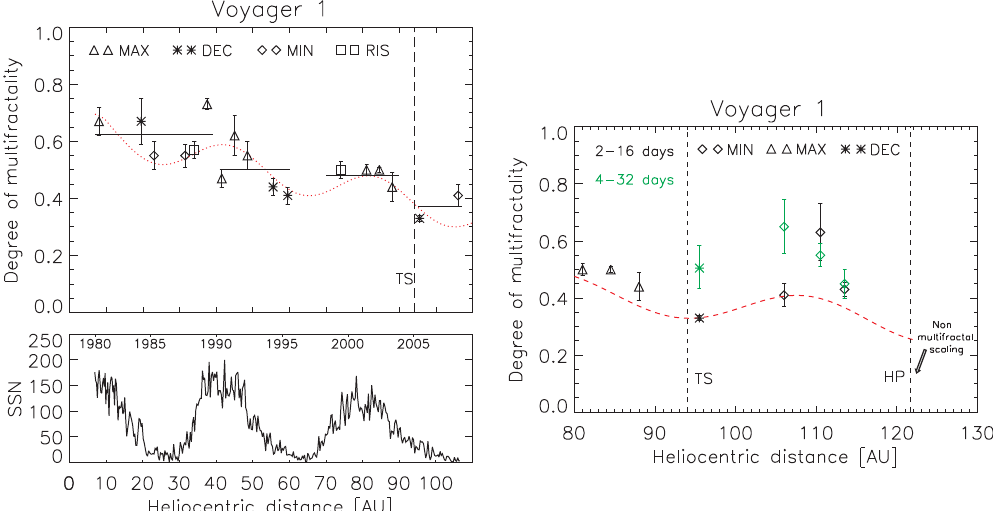
Figure 5. The parameter (cid:49) quantifying multifractality in the heliosphere as a function of the distances from the Sun together with a periodic function shown by dotted (dashed) lines during different phases of the solar cycle (SSN is the sunspot number) in the heliosphere (Macek et al., 2011) and in the heliosheath (Macek et al., 2014). The heliospheric termination shock (TS) and the heliopause (HP) crossings by Voyager 1 are